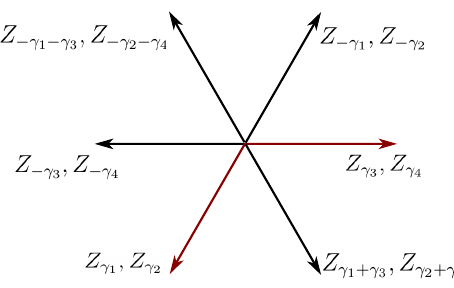
Figure 2 . Central charges of the 12 BPS states at u 1 = u 2 = 0